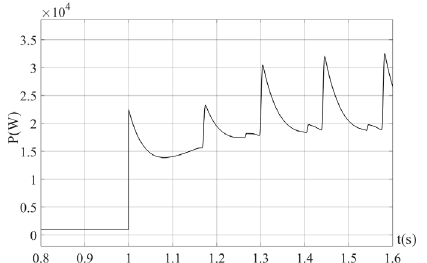
Figure 14. AC constant power load generates a power step (Group B).